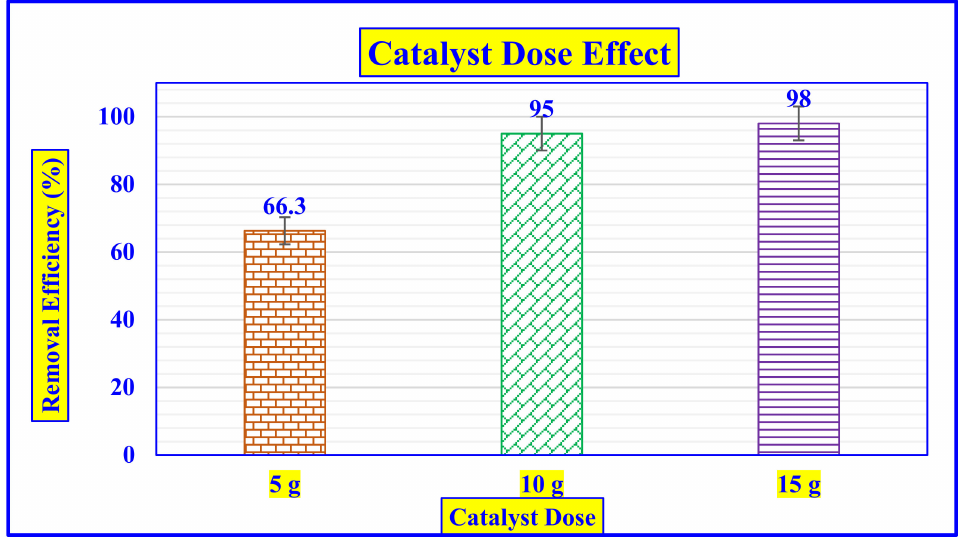
Figure 3. Catalyst dose effect on catalytic ozonation processes (As = 73 ± 4 µ g/L; O 3 = 1.0 ± 0.2 mg/min; O 3 /Fe-AC = 5 g/L, 10 g/L and 15 g/L; pH = 7.6 ± 0.2; t = 30 min; volume = 1 L; T = 25 ± 2 ◦